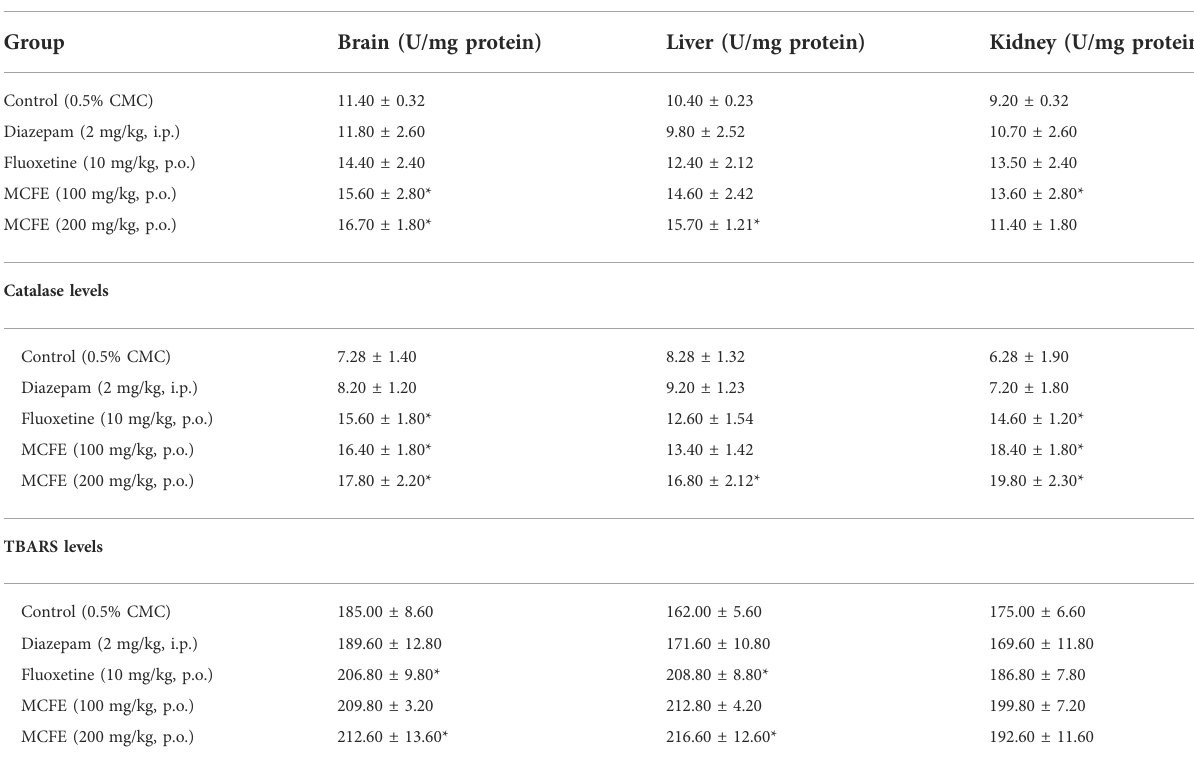
TABLE 4 Measurement of superoxide dismutase, TBARS and catalase levels in mice brain, liver and kidney on chronic administration of MCFE.